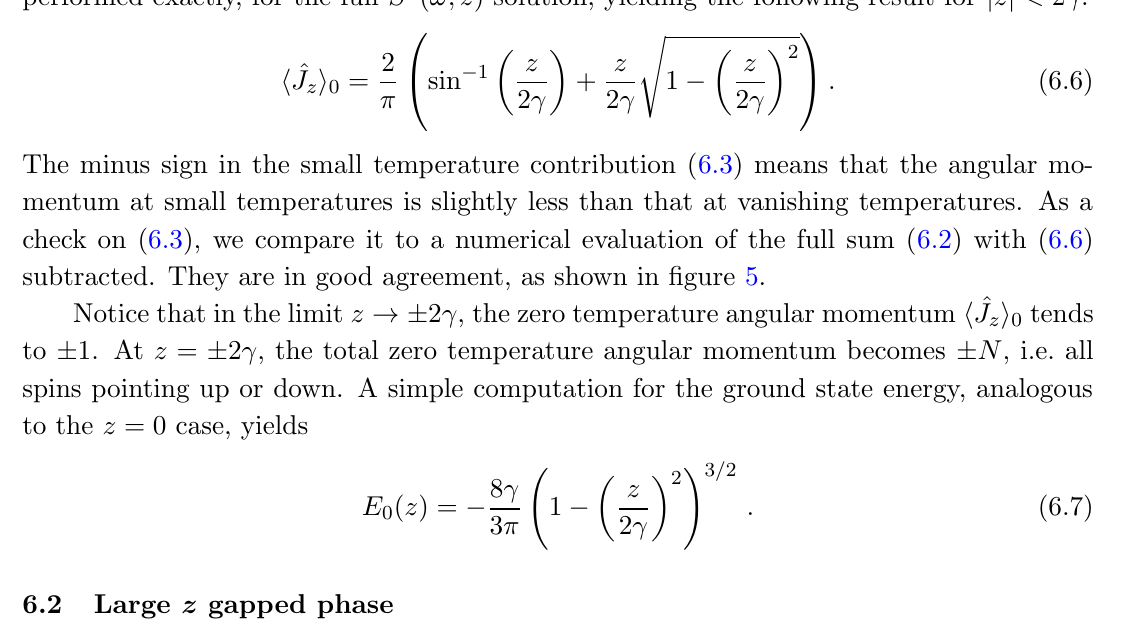
Figure 5 . Left : comparison between (cid:14)J z (cid:17) red) given in (6.3), for z = 20 (in units where (cid:12) = 1), with a cuto(cid:11) on the sum given by n c = (cid:6) 2 (cid:2) 10 4 . Note the sharp transition at (cid:13) = z= 2. Right : (cid:14)J z vs. z and (cid:13) . The red line indicates the locus j z j = 2 (cid:13)